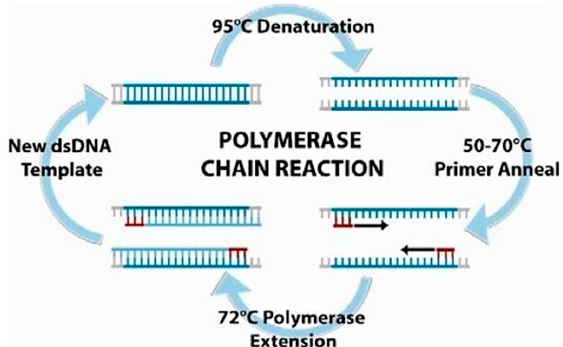
Figure 21. Polymerase chain reaction (PCR) standard protocol involves raising the temperature of the